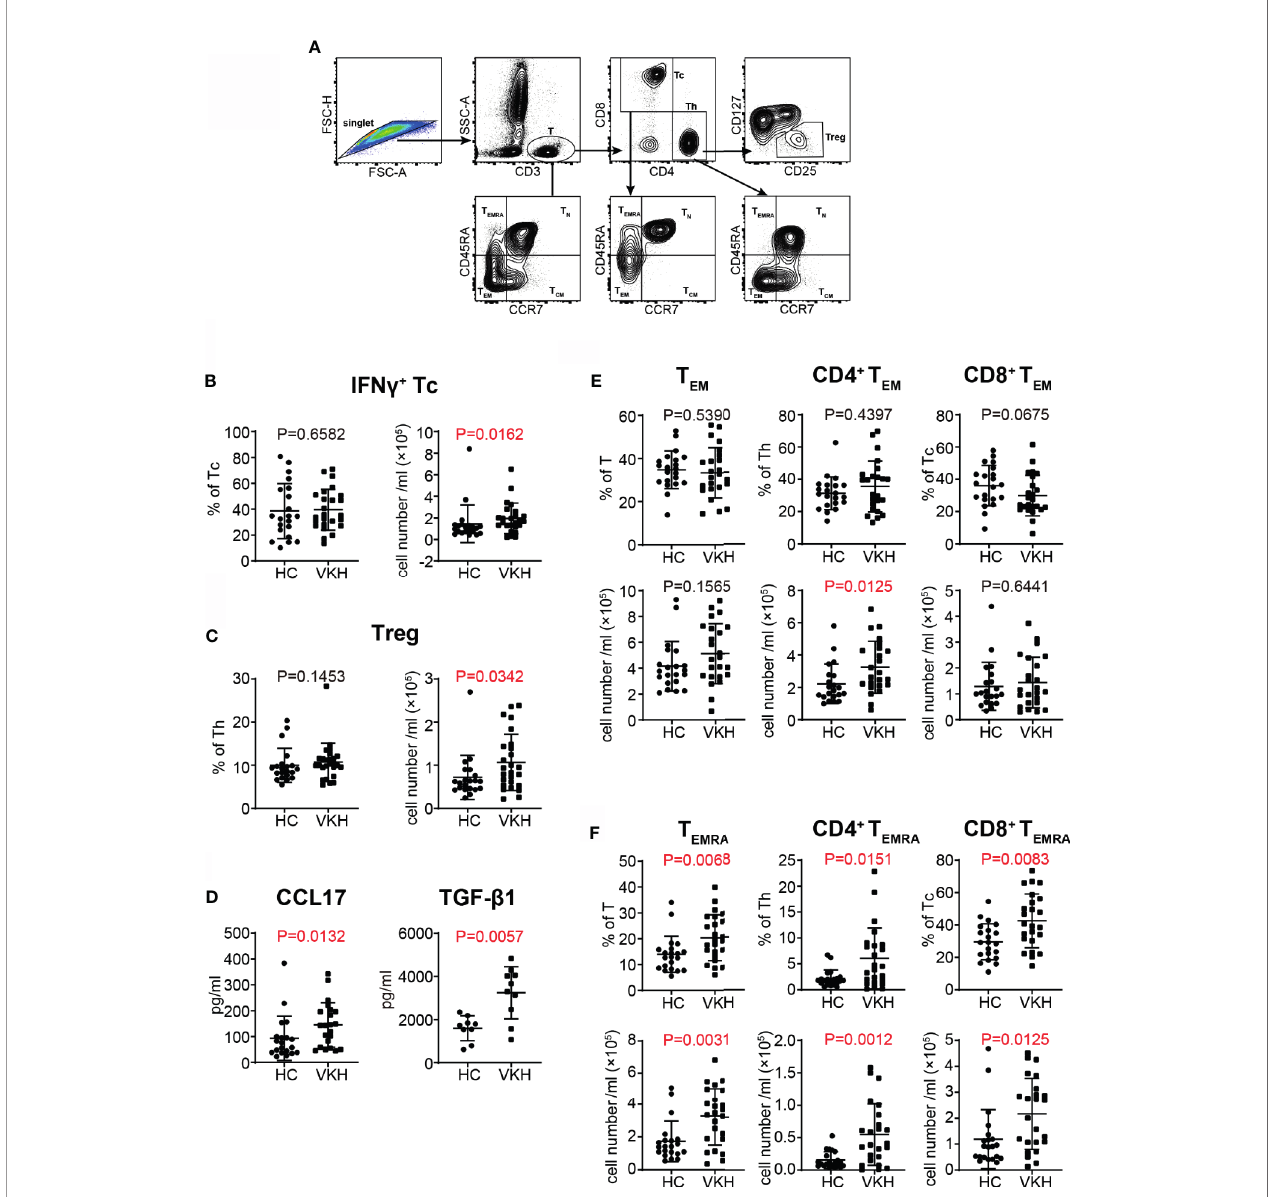
FIGURE 3 | Comparison of T cell subsets de fi ned by cytokine pro fi le and differential status between VKH patients and healthy controls. (A) Gating strategy used for T cell classi fi cation. (B) The absolute number and proportion of IFN- g + CD8+ T cell. (C) The absolute number and proportion of Treg. (D) plasma levels of CCL17 and TGF- b 1 (pg/ml) of HCs and VKH patients. (E) The absolute number and proportion of TEM in total T cells, CD4+ T and CD8+ T cells in HCs and VKH patients. (F) The absolute number and proportion of TEMRA in total T cells, CD4+ T and CD8+ T in HCs and VKH patients. Statistical analysis was performed using Mann – Whitney test. Treg, regulatory T cells; TN, naïve T cells; TCM, central memory T cells; TEM, effector memory T cells; TEMRA, CD45RA+ effector memory T